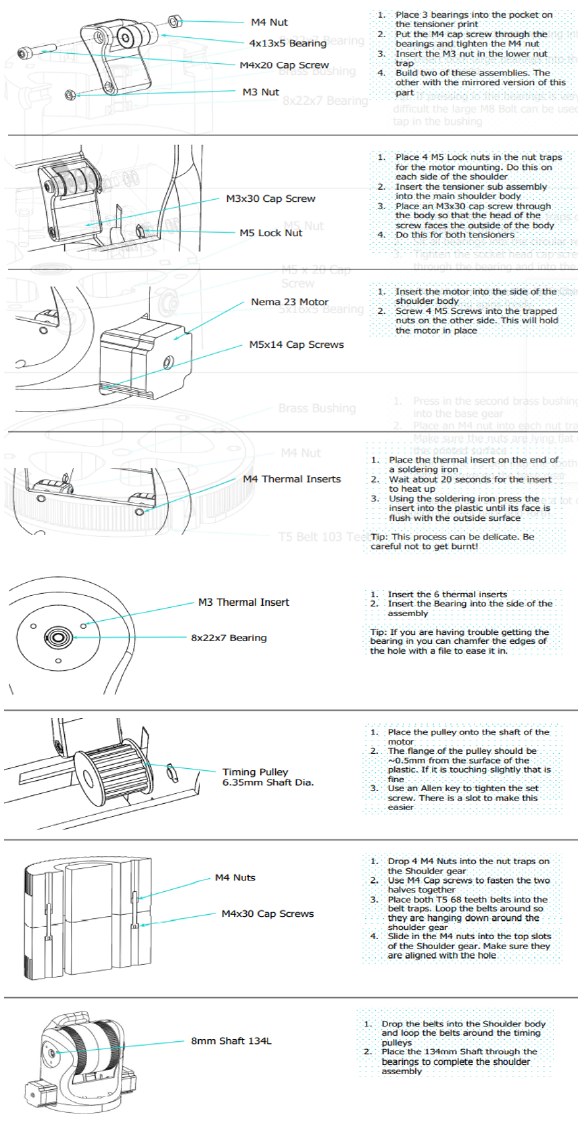
Fig. 3. Design for shoulder